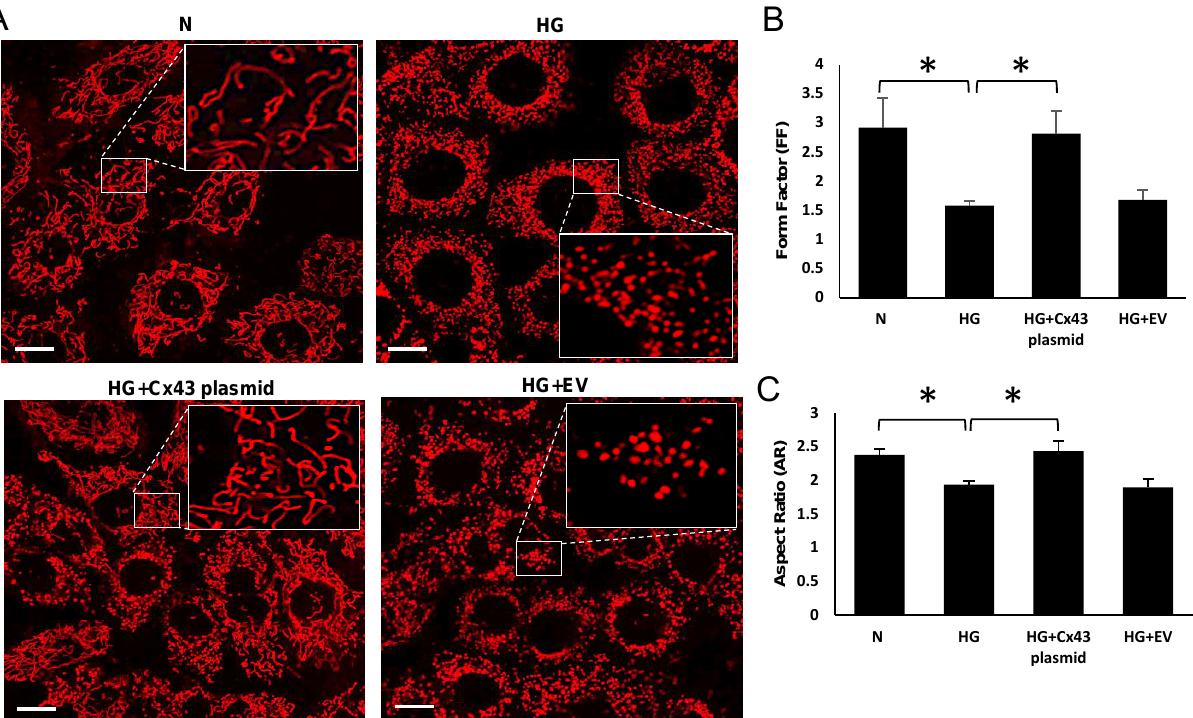
Figure 5. Effect of upregulating mtCx43 level against HG-induced mtCx43 downregulation on mitochondrial fragmentation. Plasmid-mediated Cx43 overexpression improved mtCx43 level and reduced mitochondrial fragmentation in HG condition. ( A ) Representative images of mitochondrial networks in RRECs grown in N medium, HG, HG and transfected with Cx43 plasmid or empty vector, as control. Scale bar = 10 µ m. The large inset represents an enlarged view of the corresponding field as indicated by dotted lines in each panel. The graph shows average ( B ) FF and ( C ) AR values for mitochondria in RRECs grown in HG medium and transfected with Cx43 plasmid or empty vector. Data are presented as mean ± SD, (* p < 0.05; n =